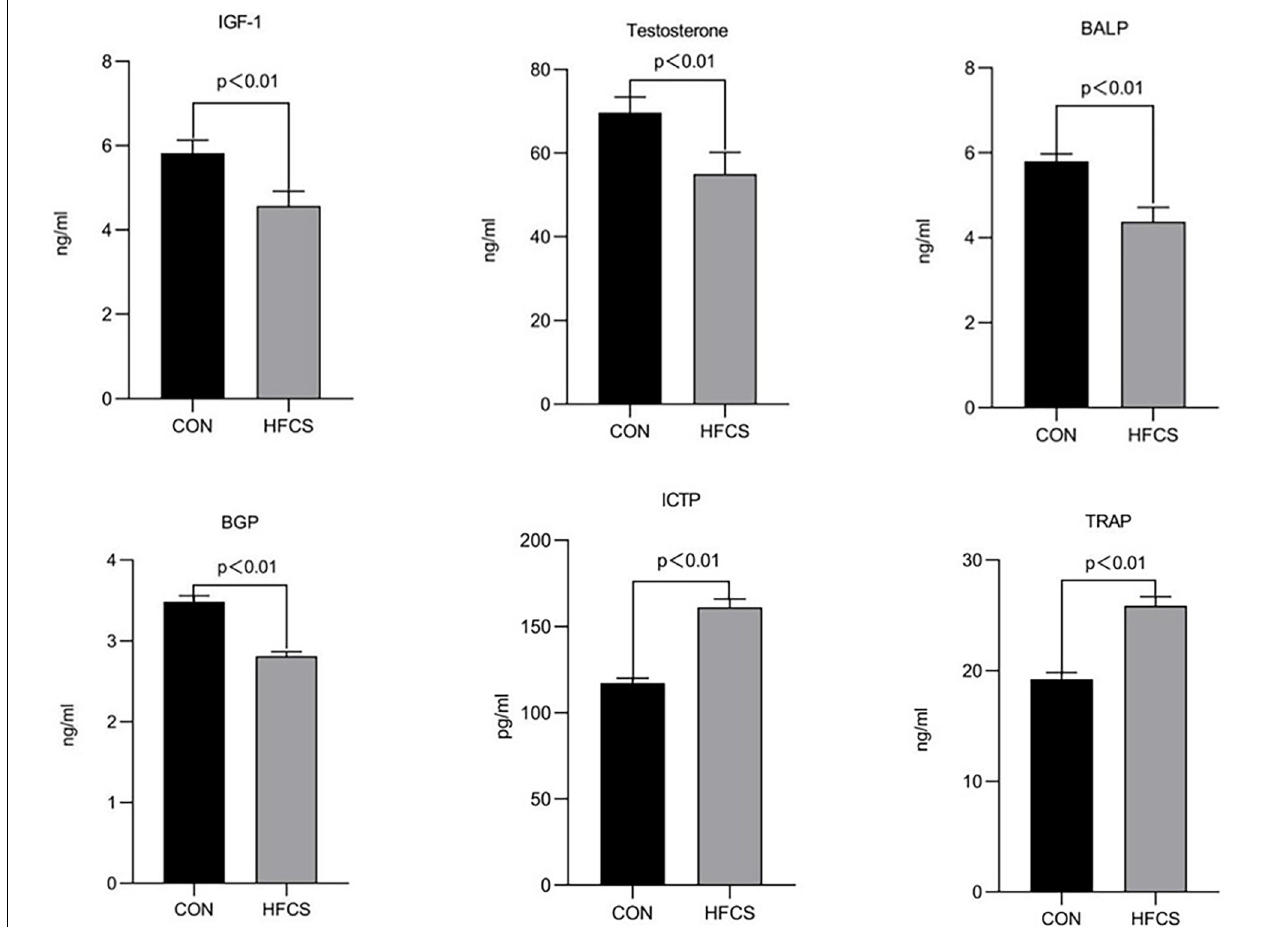
FIGURE 1 | Effect of HFCS on serum BALP, BGP, ICTP, TRAP, IGF-1, and testosterone levels in mice. CON, control; HFCS, high-fructose corn syrup; BALP, bone alkaline phosphatase; BGP, bone Gla protein (osteocalcin); ICTP, type I collagen carboxyl-terminal telopeptide; TRAP, tartrate-resistant acid phosphatase; IGF-1, insulin-like growth factor 1. All data was expressed as mean ± SEM ( n = 8) and analyzed by one-way ANOVA